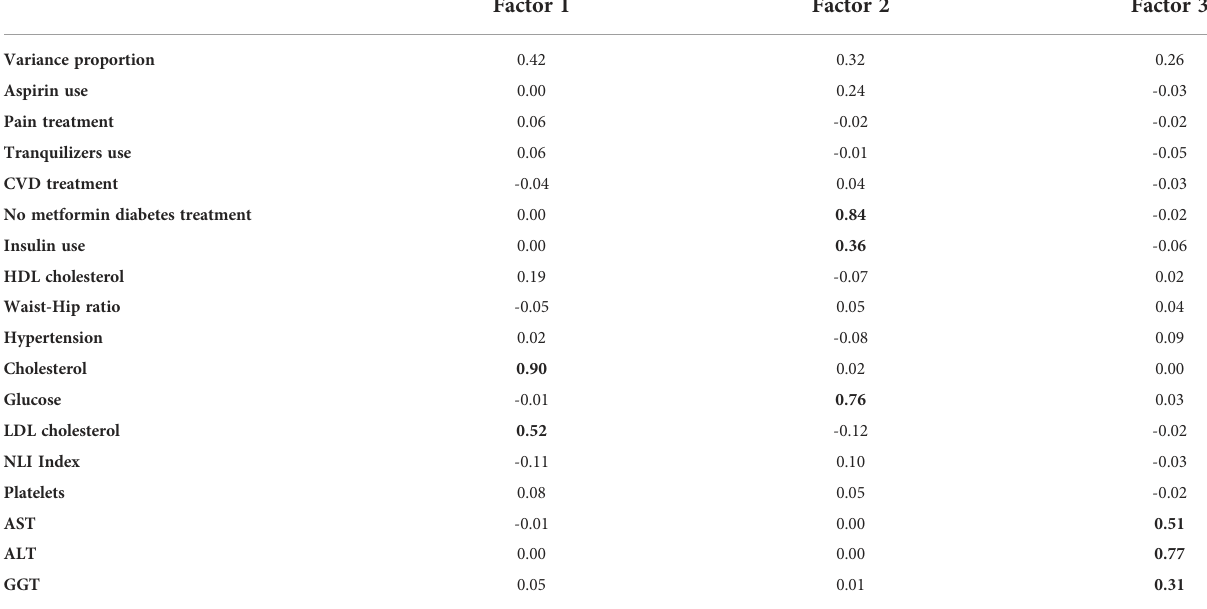
TABLE 2 Factor loading of pattern